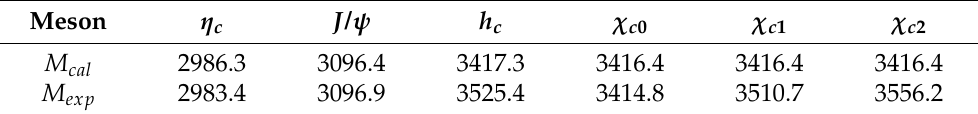
Table 2. The masses of some heavy mesons (unit: MeV). M cal and M exp represent the theoretical and experimental masses,